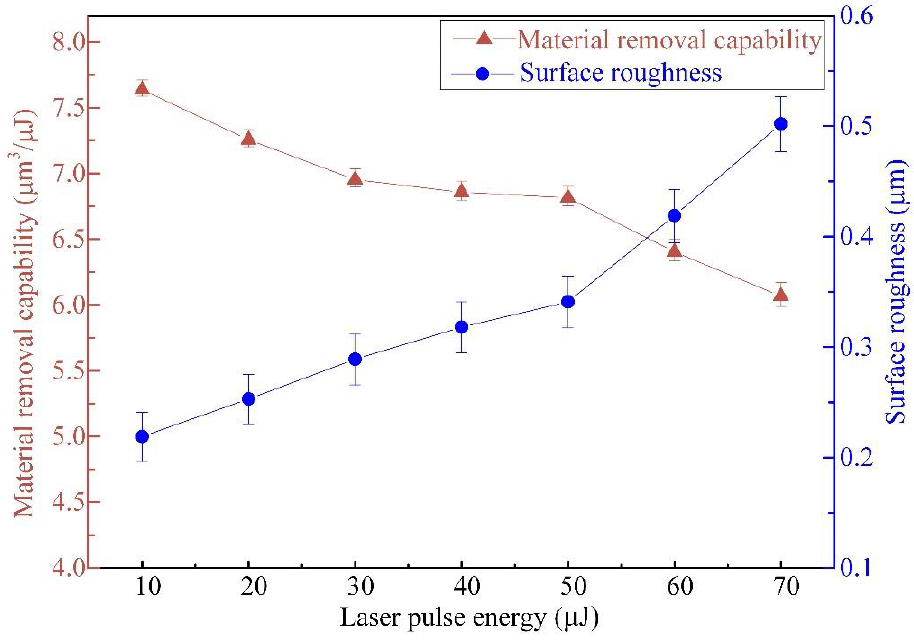
Figure 7. Effect of pulsed beam energies on the MRC and R a of micropillars at a translation velocity of 1.0 m/s and a pulsed repetition rate of 600 kHz.